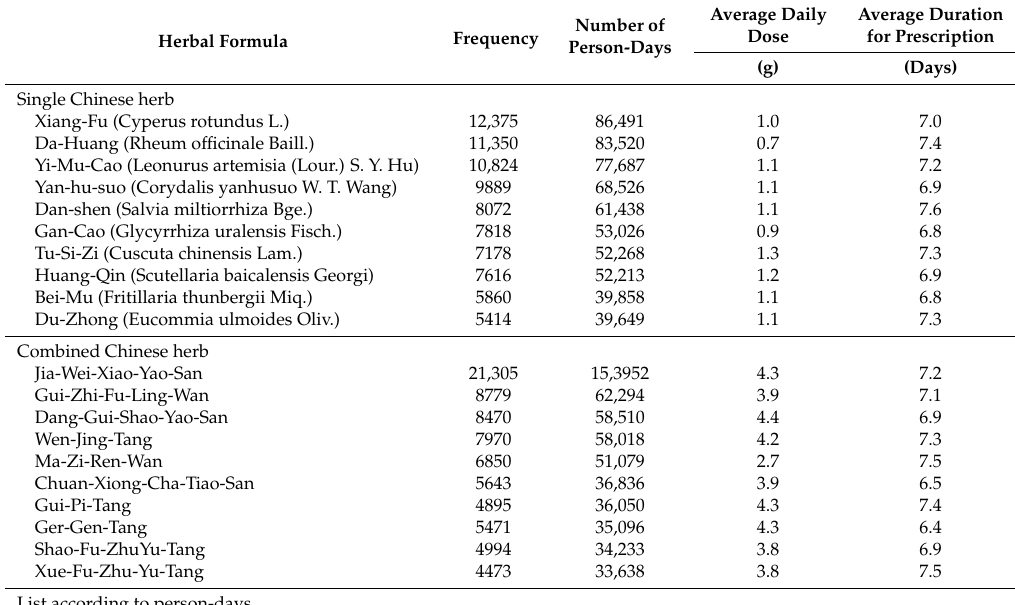
Table 3. Ten most common herbal formulas